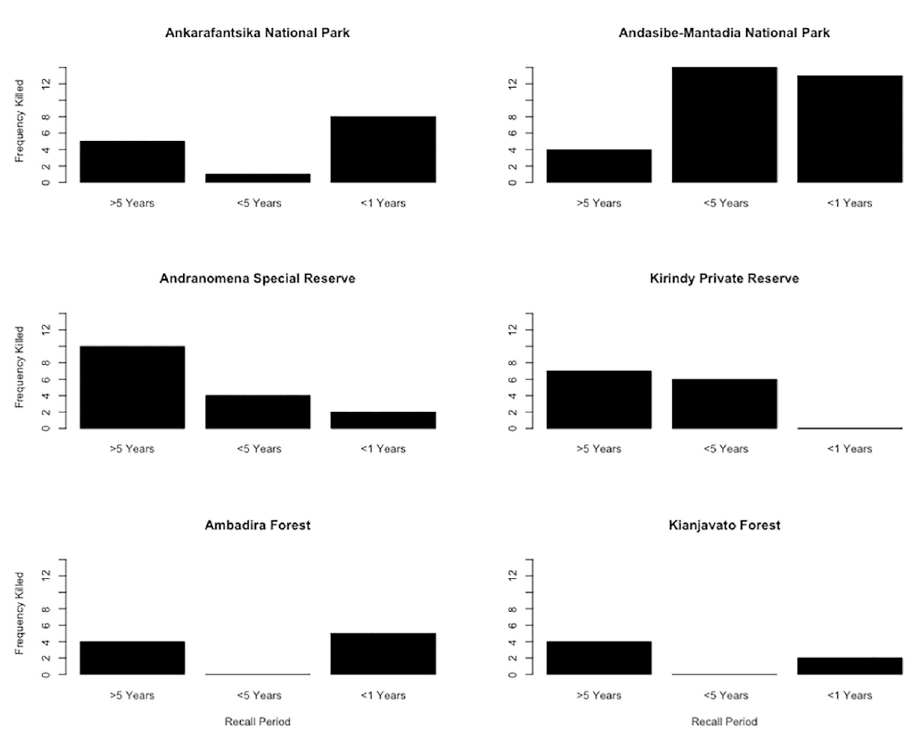
Fig 5. Interviewee estimates of the total fosas killed over the past year, five years and lifetime (each row displays national parks, reserves and unprotected forests).